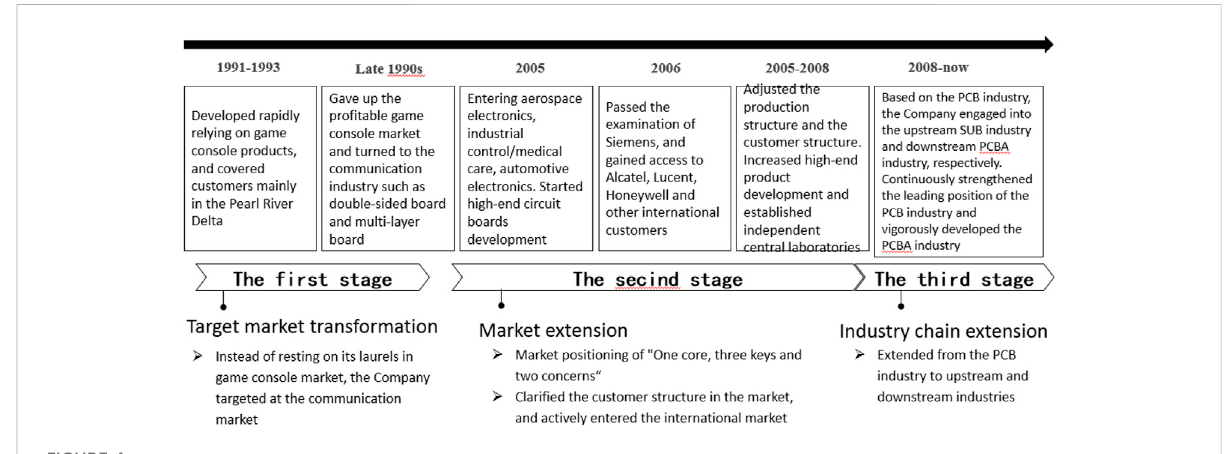
FIGURE 4 Transformation and upgrading process of Shennan